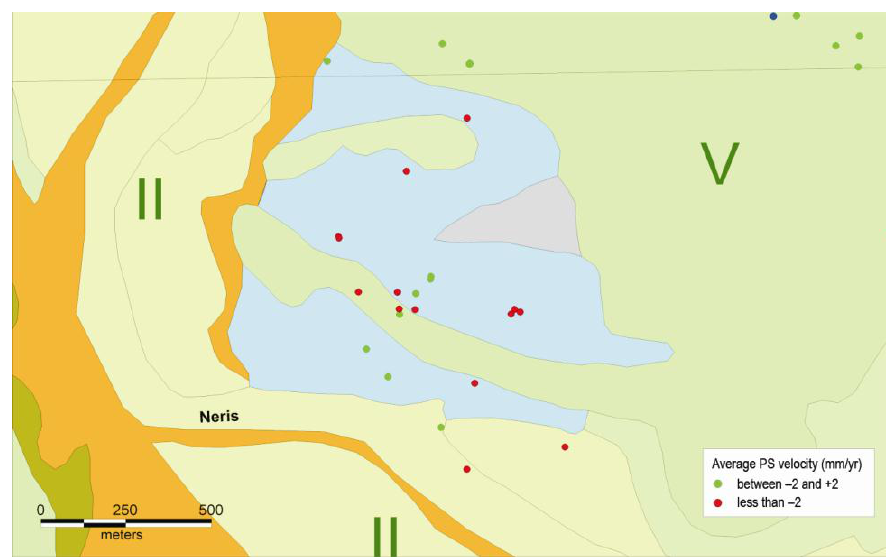
Fig. 6. Location of PS with negative velocities below – 2 mm/year (red dots) and stable points between – 2 mm/year and +2 mm/year (green dots) in Lazdynėliai